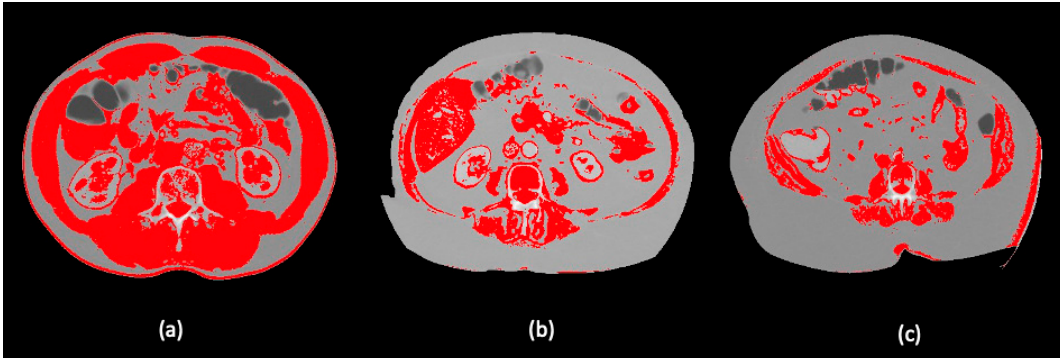
Figure 1. Selection of axial ( a ) and sagittal ( b ) slices at the level of the third lumbar vertebra in a preparatory computed tomography study.